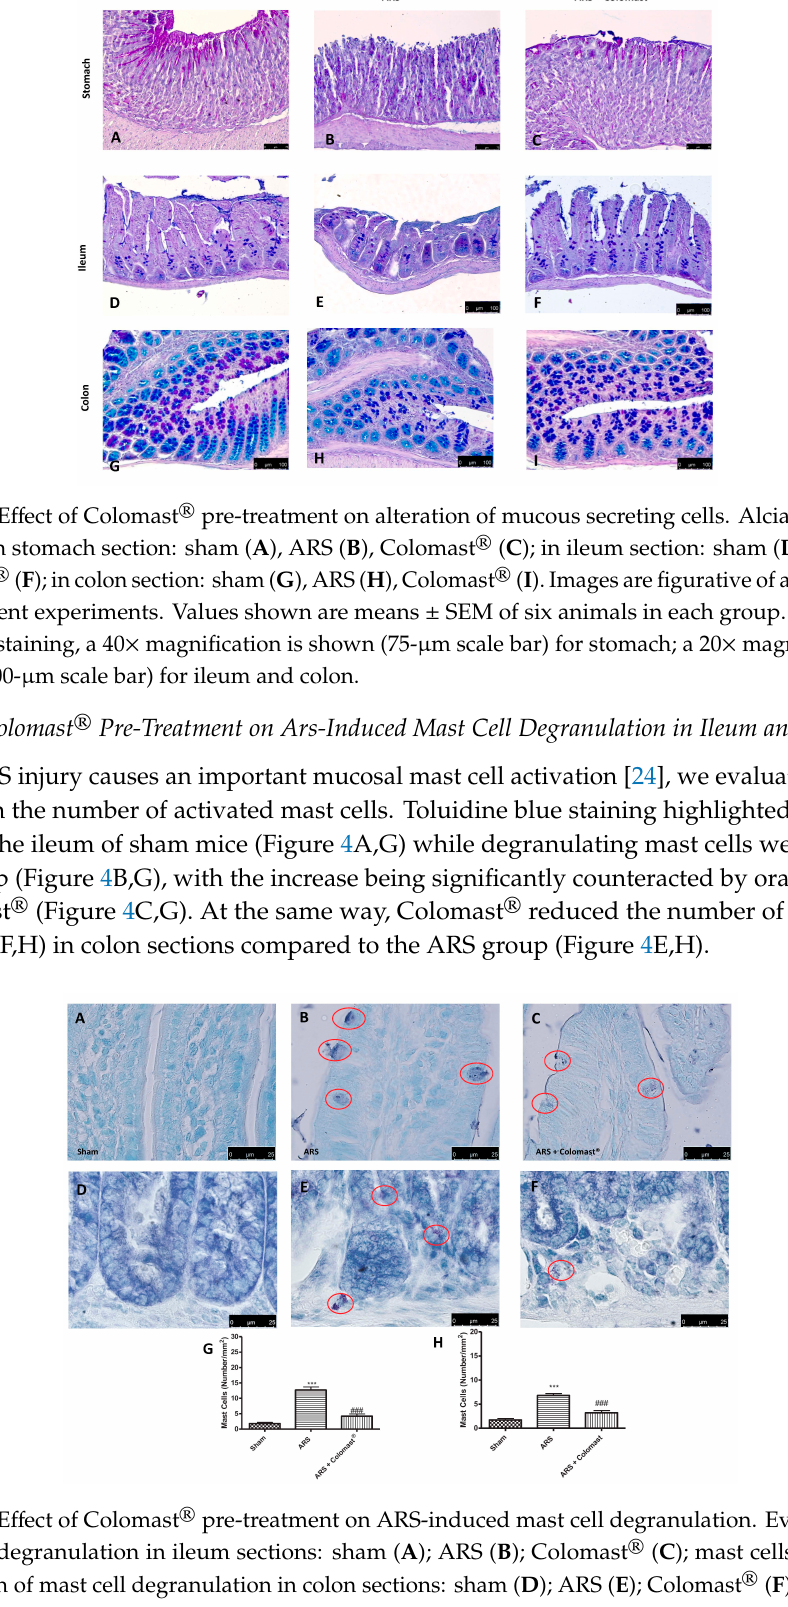
Figure 4. Effect of Colomast ® pre-treatment on ARS-induced mast cell degranulation. Evaluation of mast cell degranulation in ileum sections: sham ( A ); ARS ( B ); Colomast ® ( C ); mast cells count ( G ). Evaluation of mast cell degranulation in colon sections: sham ( D ); ARS ( E ); Colomast ® ( F ); mast cells count ( H ). The red circle indicated mast cells. Images are figurative of at least three independent experiments. Values shown are means ± SEM of six animals in each group. For the mast cells, a 100× magnification is shown (25-µm scale bar). *** p < 0.001 vs. sham; ### p < 0.001 vs. ARS group.